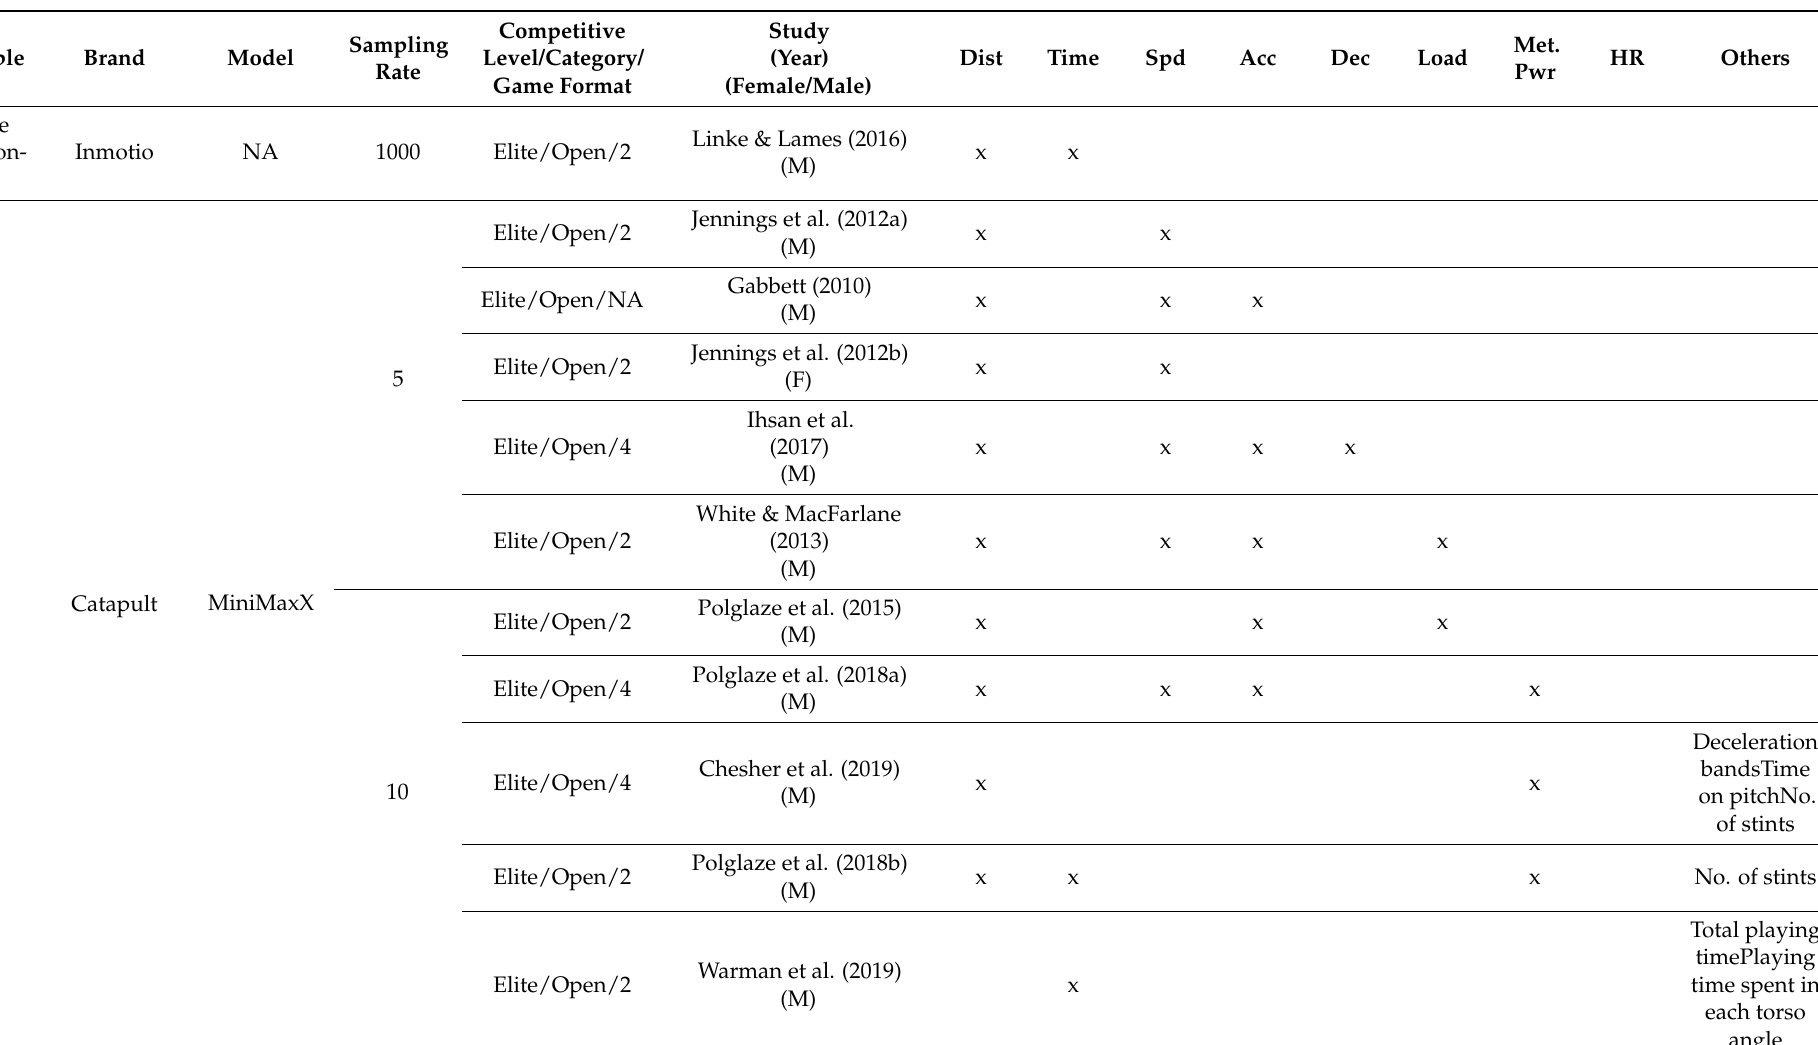
Table 1. Study characteristics, wearable specifications, and measured parameters in field hockey competition